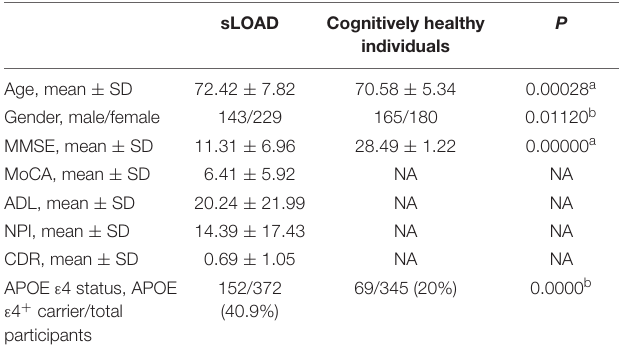
TABLE 1 | Demographic data and neuropsychological assessment of the subjects.